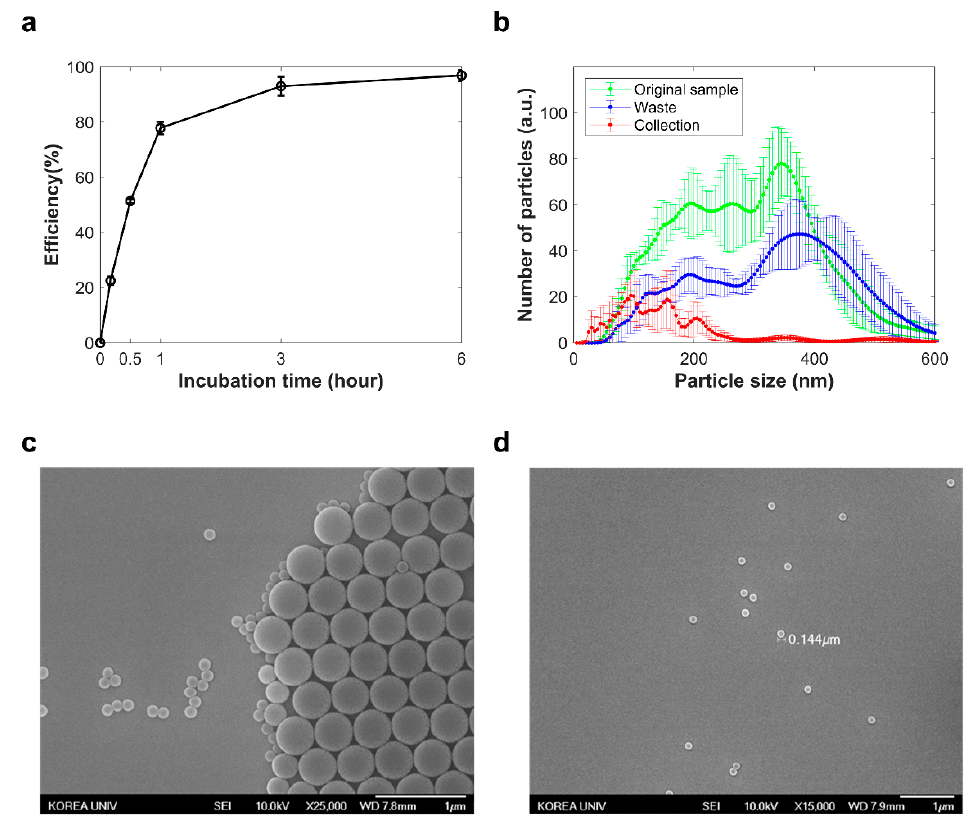
Figure 2. Separation results for nano-sized materials. ( a ) The separation efficiency of bovine serum albumin over time at the outlet chamber. ( b ) NTA result for polystyrene particle mixture before and after separation. ( c ) SEM image of the samples from inlet chamber and ( d ) outlet chamber.